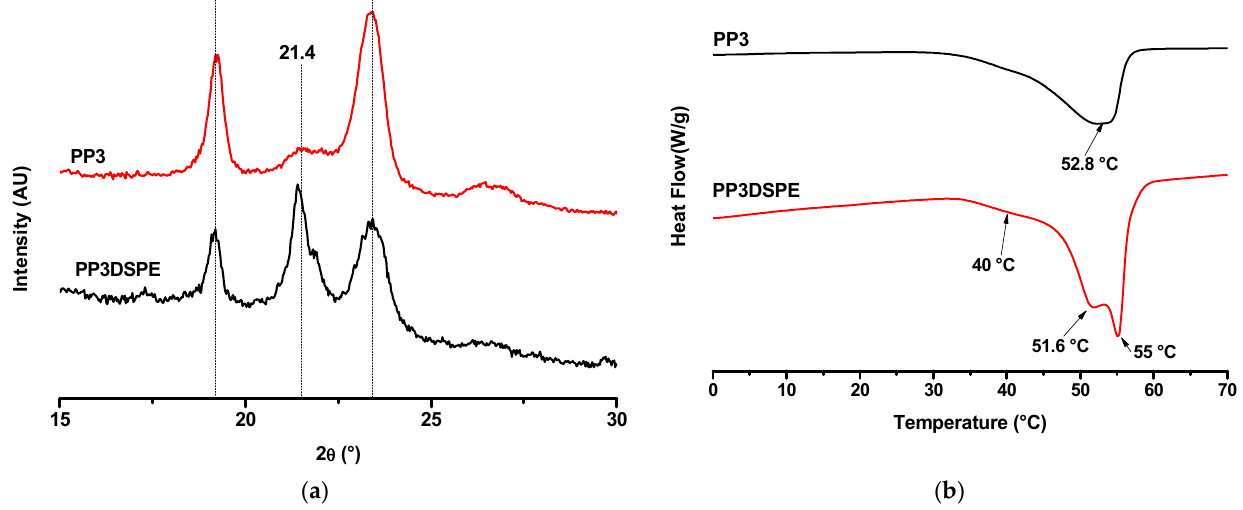
Figure 5. Characterisation of lyophilised formulations based on PP3 and PP3-DSPE. ( a ) DRX profiles and ( b ) DSC traces.